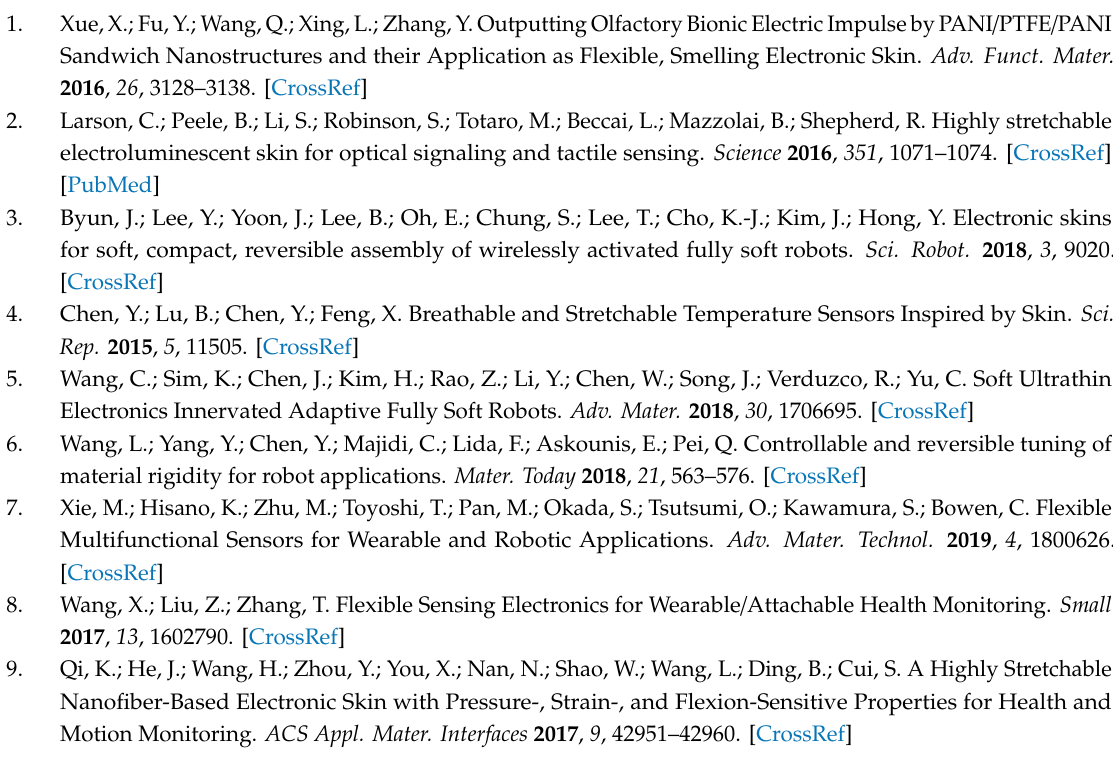
Figure S1: The frames and squeegee for printing the samples, Figure S2: Experiment for determining the breathability of the sensors, Video S1: The operation of e-fabric skin in a real